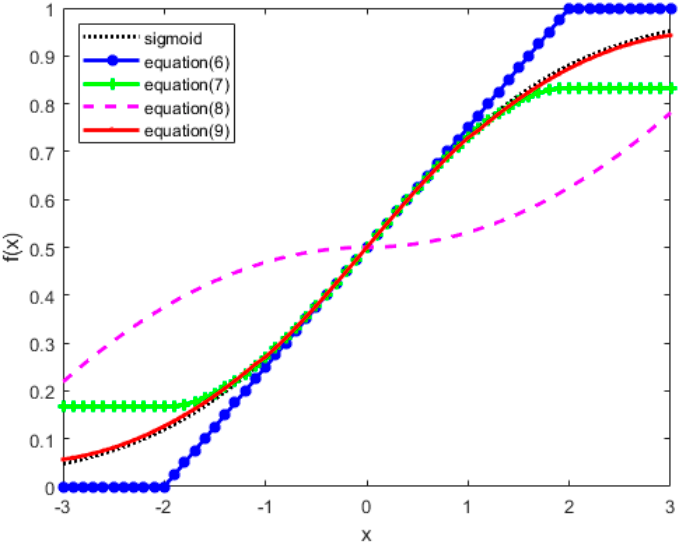
Figure 2. Comparison of different sigmoid functions.